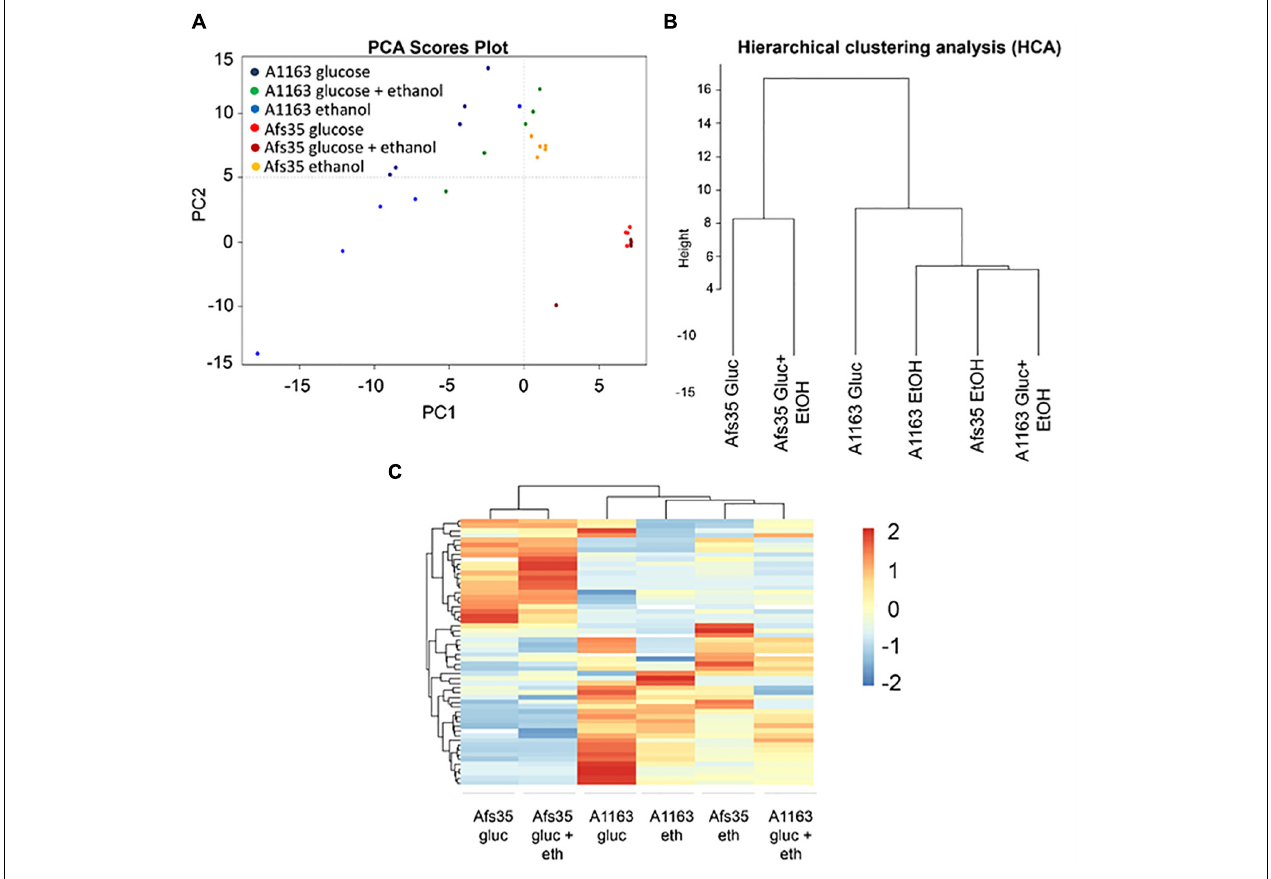
FIGURE 4 | (A) Principal component analysis (PCA) of all five replicates and (B) hierarchical clustering analysis (HCA) based on the average of five replicates of the quantities of all significantly different metabolites identified between strains Afs35 and A1163 in each of the three above conditions. (B) HCA shows the proximity relationship between strains and conditions based on the average quantity of identified metabolites. (C) Heat map based on the relative average quantities of five biological replicates of all significantly different metabolites identified between strains Afs35 and A1163 when cultivated in glucose, ethanol or glucose and ethanol.